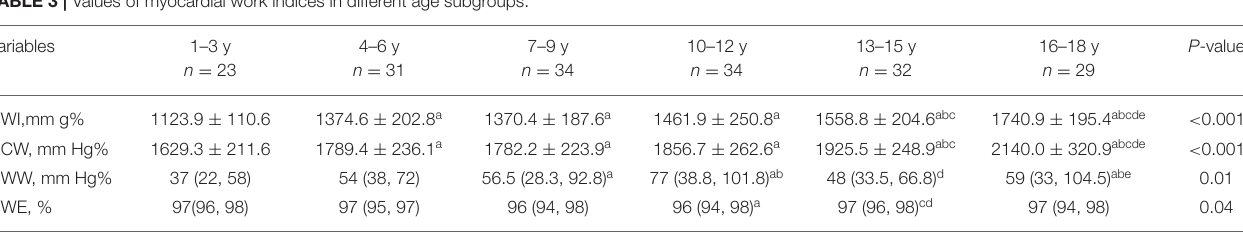
TABLE 3 | Values of myocardial work indices in different age